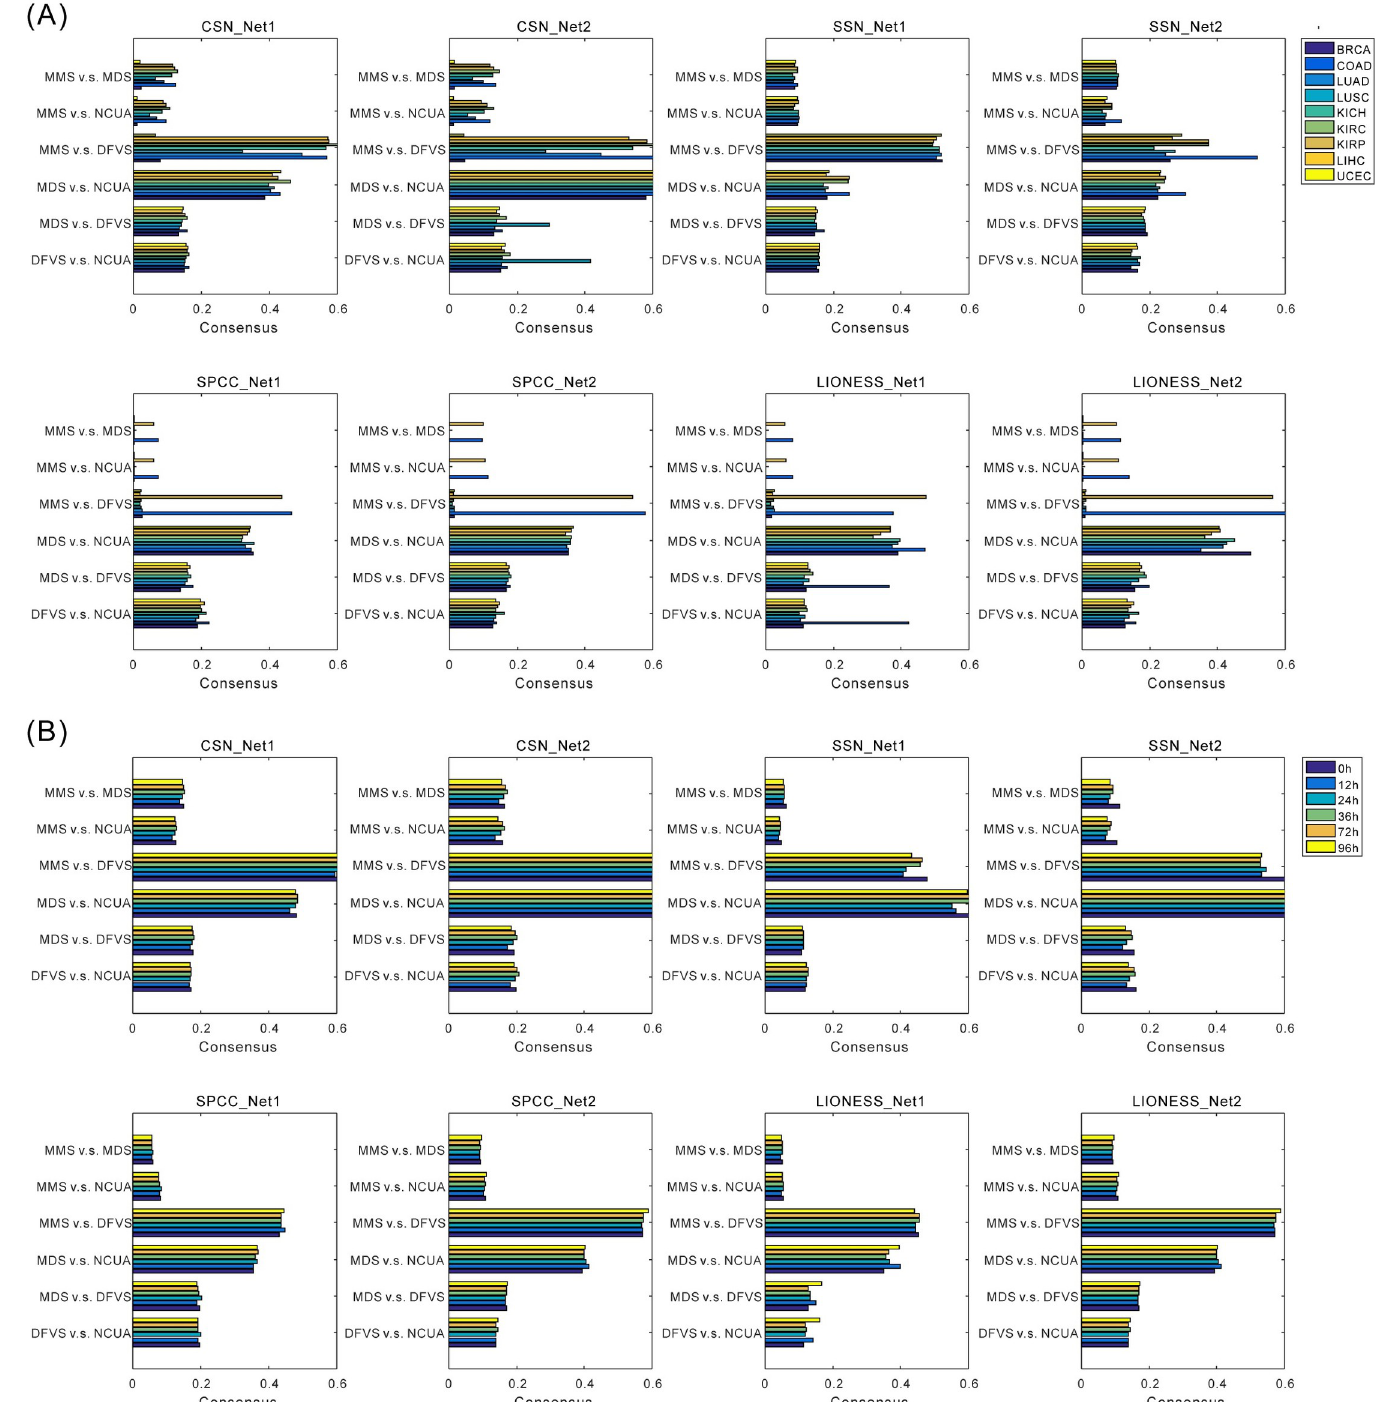
Fig 9. Evaluation of identification consensus among structural control methods. The comparisons are carried on any two control methods using (A) nine TCGA cancer datasets, and (B) temporal single cell datasets.